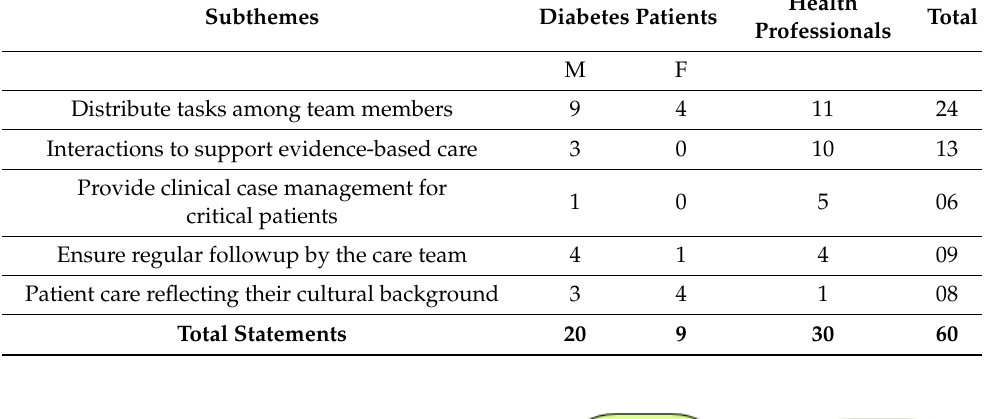
Table 3. Delivery system design outcome.